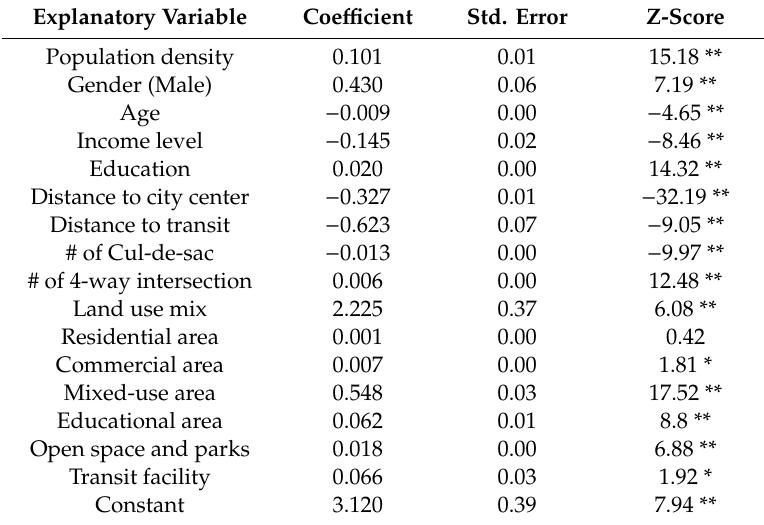
Note: ** significant at 0.05 level, * significant at 0.10